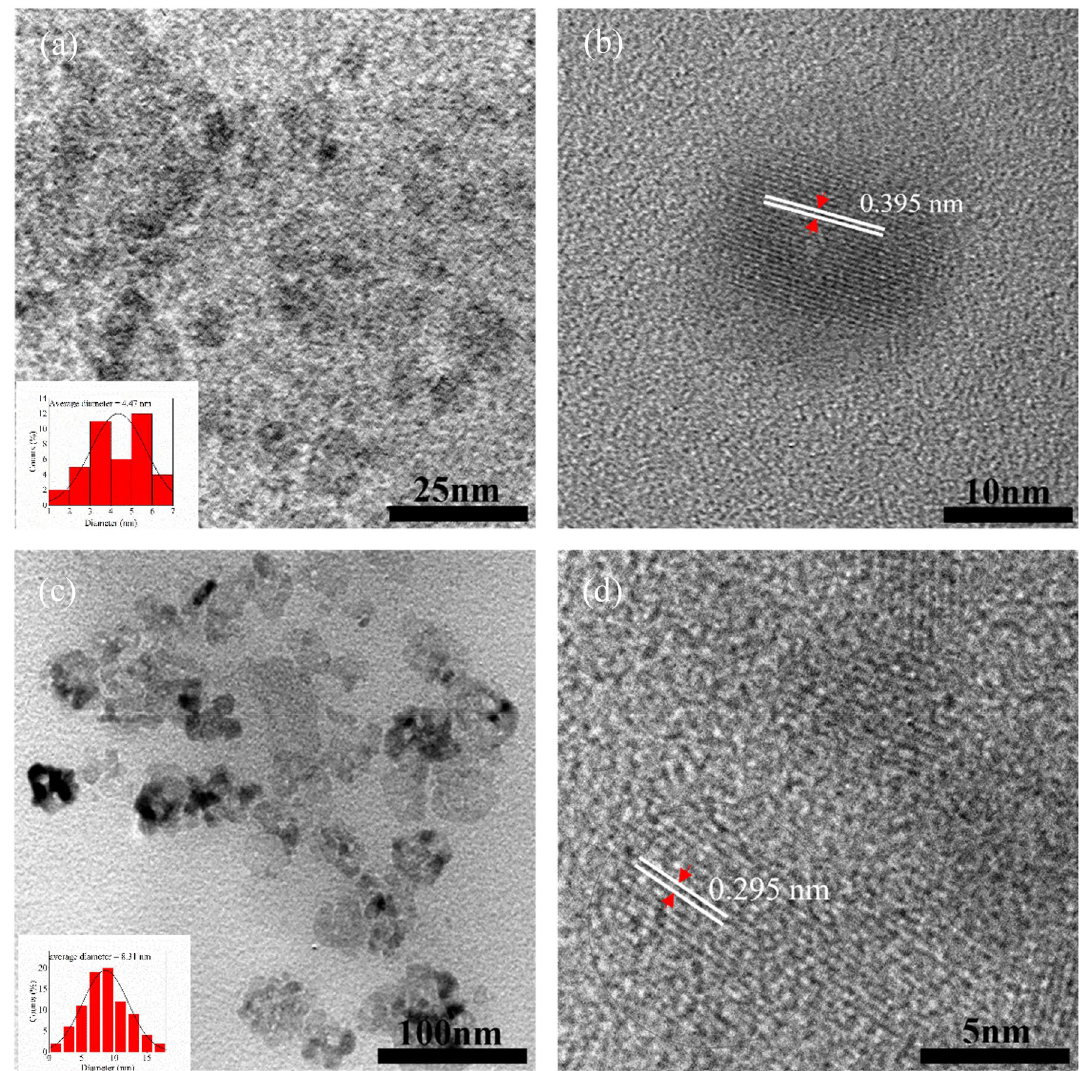
Figure 3. ( a ) HR-TEM images with size distribution histogram inset, ( b ) HR-TEM image of a typical CDs, showing the solidified graphite liner core of CDs at 220 °C for 6 h (CDs-220C-6h), ( c ) HR-TEM images with size distribution histogram inset, ( d ) HR-TEM image of a typical CDs, showing the solidified graphite liner core of CDs at 220 °C for 10 h